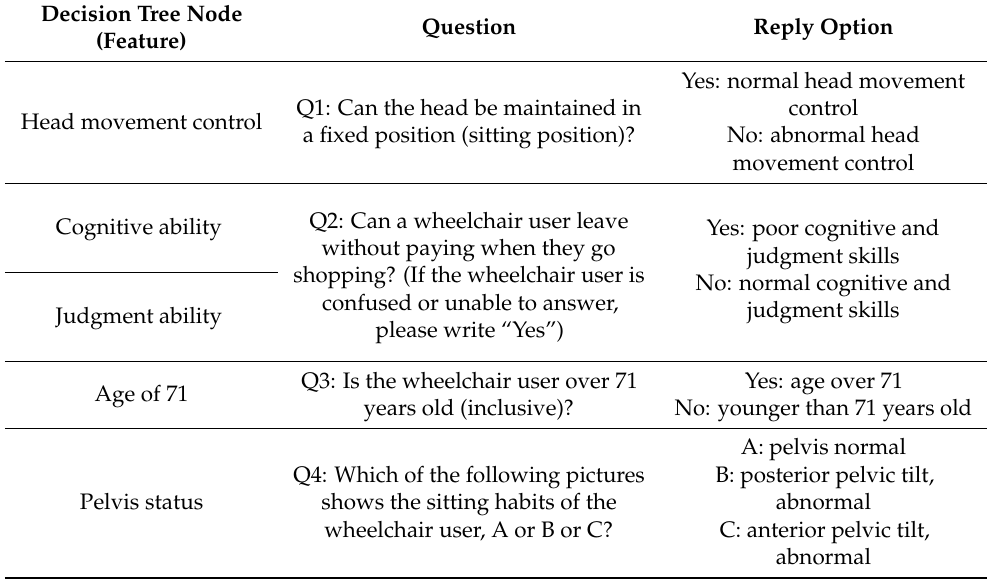
Table 3. LINE BOT assessment